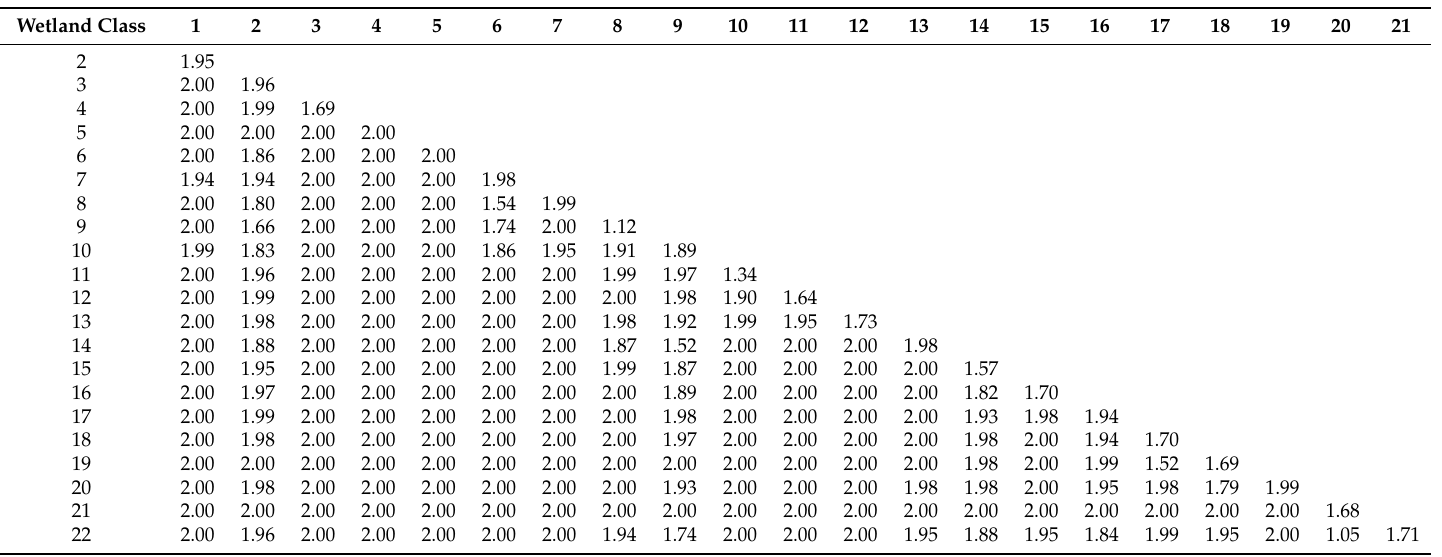
Table 3. Jeffries-Matusita (J-M) distance measure of class separability for input predictor variables combination of WV2 bands 1–8; the table-wide J-M value was 1.95, indicating high overall